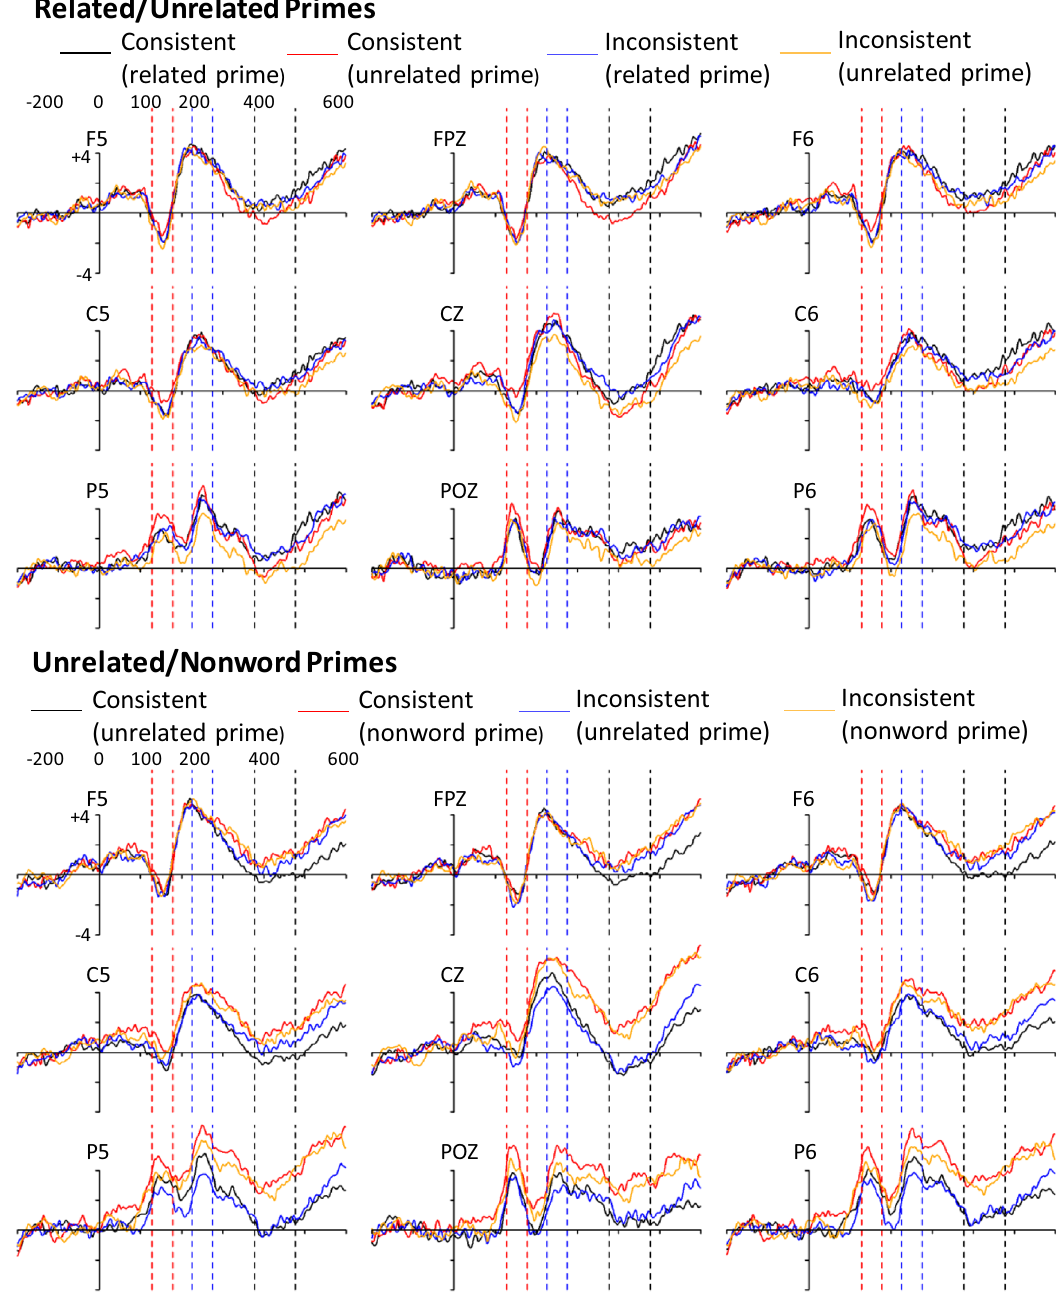
Figure 3. Example grand-average ERPs for different electrodes in both prime groups. The red horizontal lines are the N1 window, the blue horizontal lines the P2 window, and the black horizontal lines are the N400 window. Note: ERPs in the pictures were smoothed using R’s smooth.spline function with a spar parameter of 0.1, but statistical analyses was done on the data before